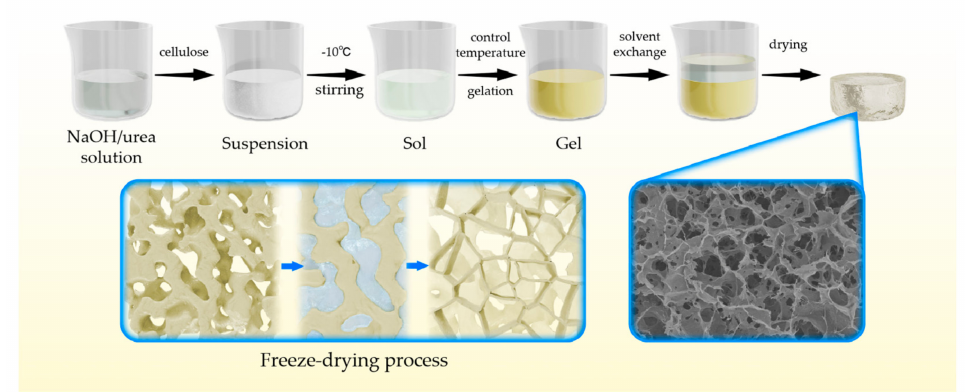
Figure 1. Schematic illustration of cellulose aerogel preparation in NaOH/urea